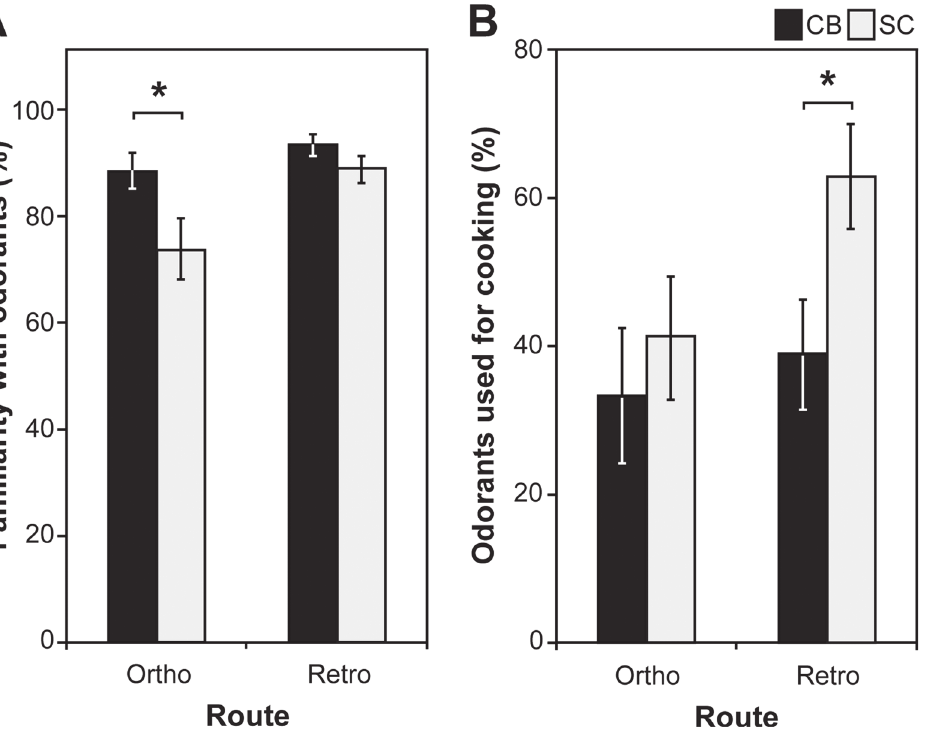
Fig 2. Subjective experience with odours. Data are presented as mean ± SEM. A. Congenitally blind (CB) are more familiar with the orthonasal odours and B. use less retronasal odours for cooking than sighted controls (SC). * Significant at p <